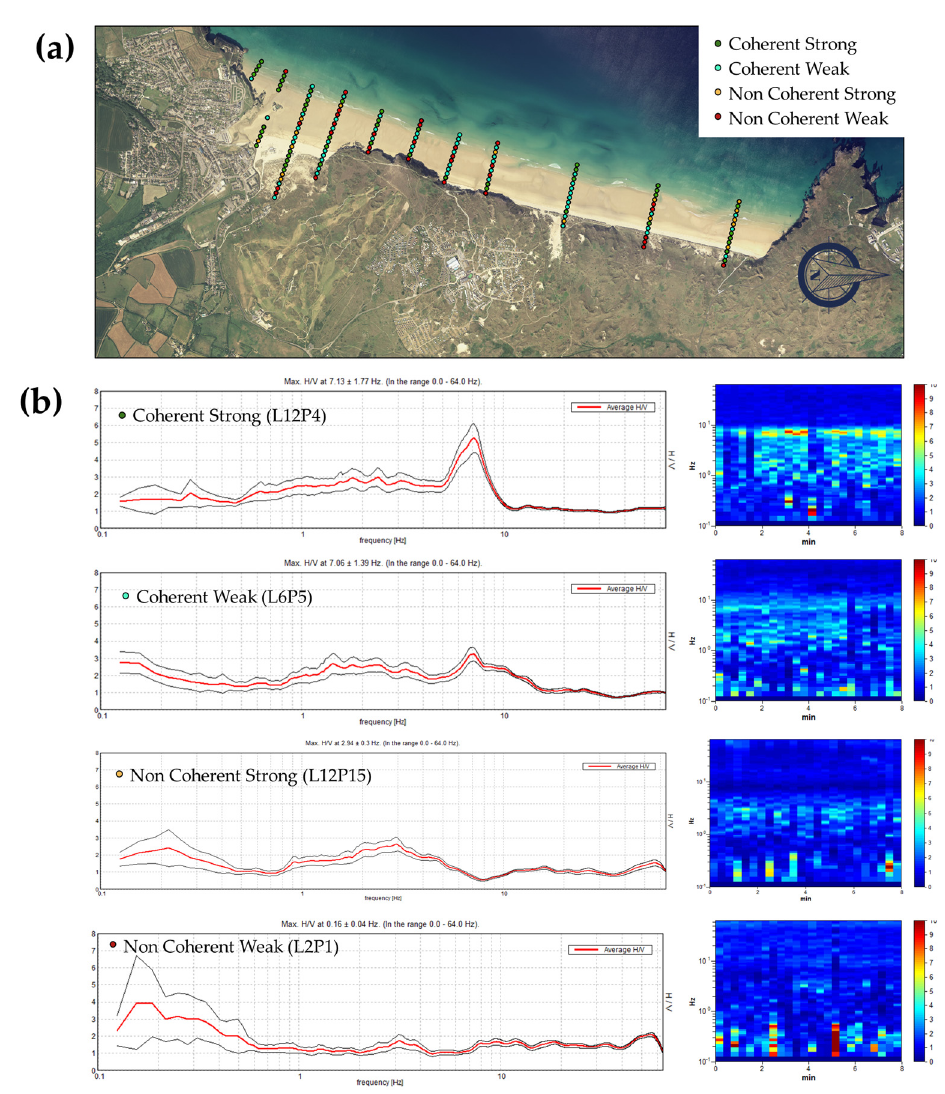
Figure 8. Summary of the 149 recorded single station measurements illustrating the ( a ) spatial distribution of the Tromino sample points displaying the four quality categories of the data collected and ( b ) representative H/V time history and horizontal to vertical spatial ratio plots for each of the four